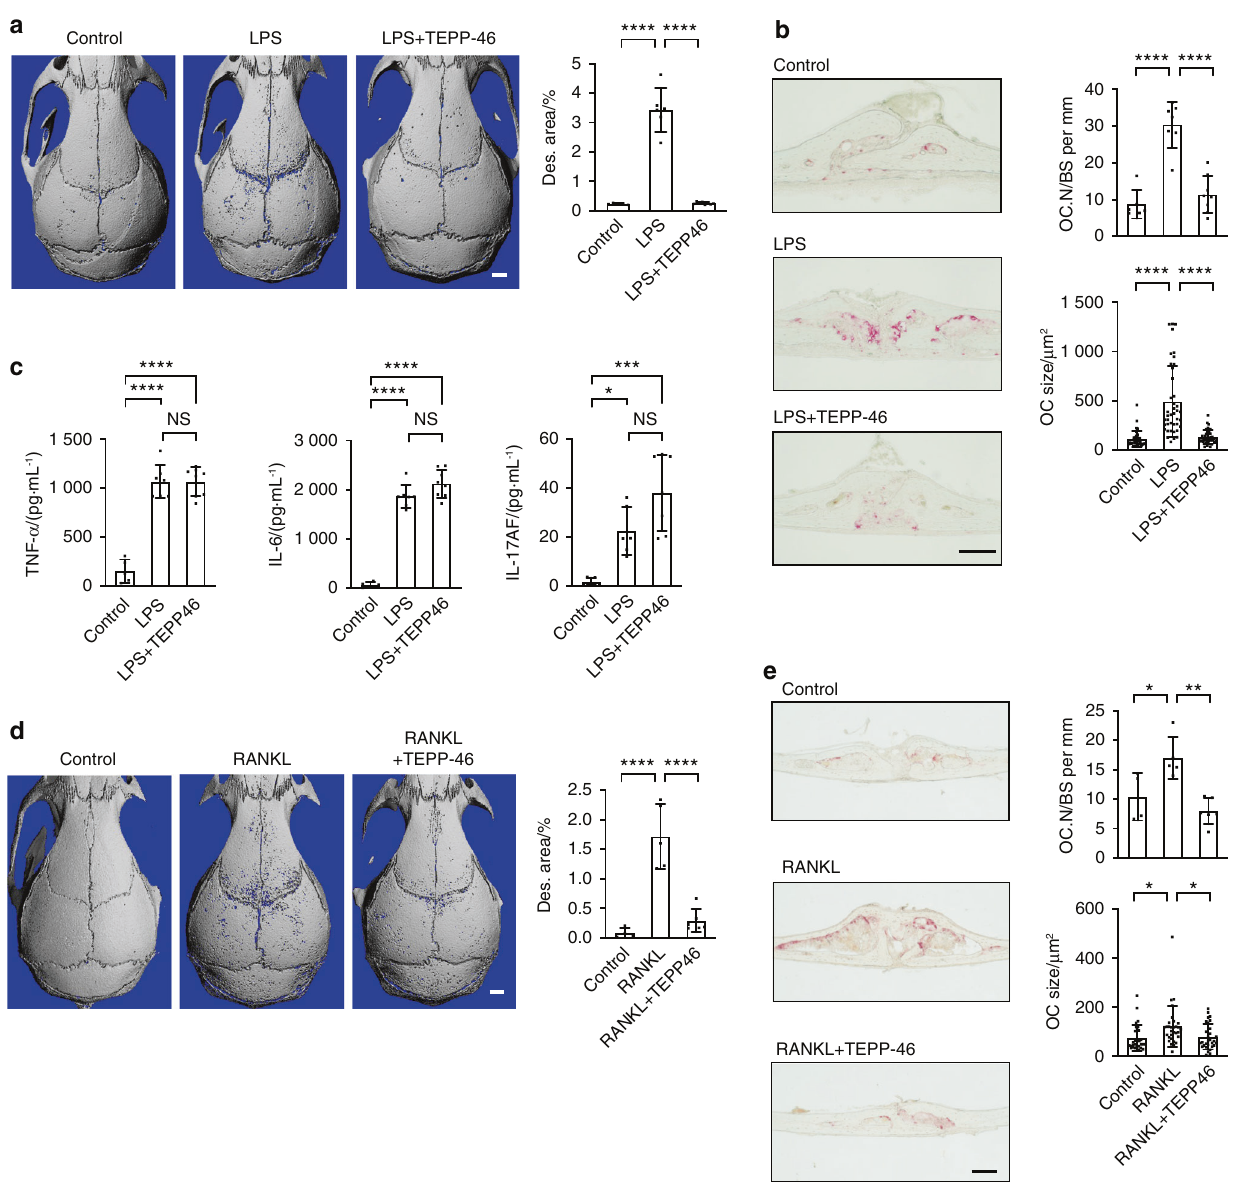
Fig. 5 The activation of PKM2 attenuates LPS-induced osteoclastic bone loss. a Representative μ CT images of mouse calvaria 5 days after LPS injection with or without TEPP46 ( n = 5 – 6 mice per group). The scale bar represents 1 mm. Percentages of the bone destruction areas (Des. area) in calvaria are shown. b Representative TRAP staining images of calvarial coronal sections in ( a ). TRAP + osteoclast size (OC size) and number (OC.N/BS) are shown. Scale bar represents 200 μ m. c Serum levels of TNF- α , IL-6, and IL-17AF in the mice in ( a ) are shown. d Representative μ CT images of mouse calvaria at 4 days after RANKL injection with or without TEPP46 are shown ( n = 4 – 6 mice per group). The scale bar represents 1 mm. e Representative TRAP staining images of calvarial coronal sections in ( d ). The scale bar represents 200 μ m. Each dot represents the result of a single mouse. Each dot in OC size represents the result of a single osteoclast. The data are presented as the means ± osteoclast differentiation and bone metabolism. Although Shiko- PKM2 phosphorylation might not be required for the early phase nin has been reported to have an inhibitory effect on p65-NF- κ B of osteoclast differentiation. However, it may be important for the activation in macrophages, 54 we found that neither Shikonin nor later phase. we previously revealed that the early stage of differentiation was unaffected in IgSF11 − / − cell cultures. 21 TEPP46 affected RANKL-induced NF- κ B signaling in osteoclasts (Fig. S5), con fi rming the speci fi city of these small molecules. Additionally, we showed that the basal level of phospho-PKM2 Moreover, the importance of PKM2 activity in osteoclasts and was similar in IgSF11 + / + and IgSF11 − / − BMMs (Fig. 2c), and their bone metabolism was more prominent under pathological proliferation during the early phase of osteoclast differentiation conditions. In fl ammation causes bone loss due to the induction was not affected (data not shown). These results suggest that the of multinucleated osteoclasts, and this effect was signi fi cantly increased inhibition of PKM2 activity by phosphorylation at Y 105 mitigated by the administration of a PKM2 activator. We found via IgSF11 activation is necessary for full osteoclast differentiation. that in fl ammatory stimuli, such as IL-1 β and TNF- α , enhanced the Using small molecules to speci fi cally modulate PKM2 activity, we phosphorylation of PKM2 in RANKL-induced osteoclasts (Fig. S6), showed that controlled PKM2 activity is required for proper